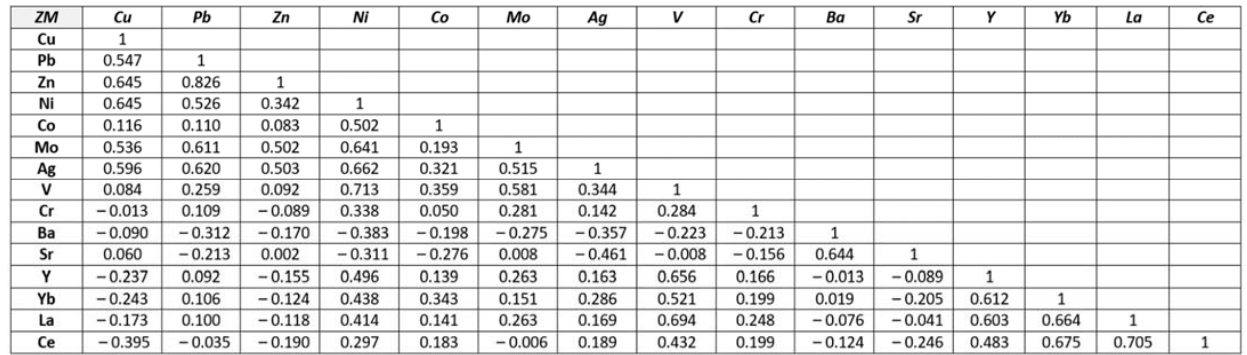
Figure 8. Correlation coefficient of chemical components in ZM. The highest Pearson coefficient indicate pairs: Zn–Pb, Ni–Mo, Ag and V, Ba–Sr, La-Ce–Yb.